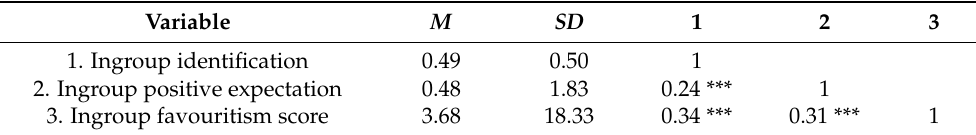
Table 2. Correlations among the key variables in Study 2 ( N = 332).